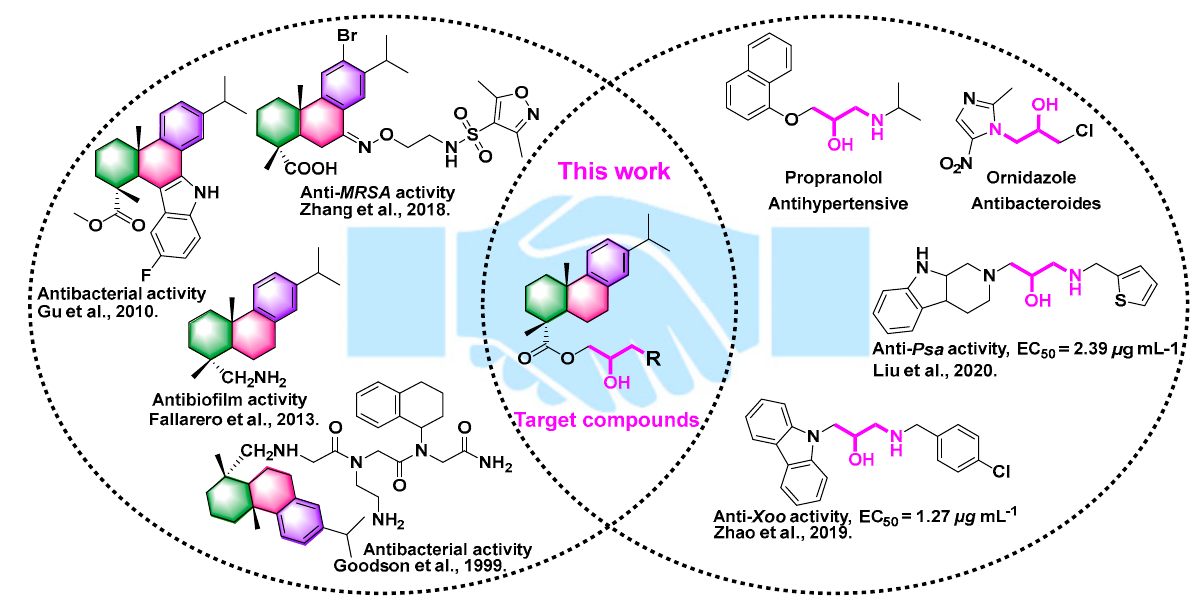
Figure 1. Some commercial and reported bioactive structures with an amino alcohol moiety and dehydroabietic acid and the method for producing target molecules